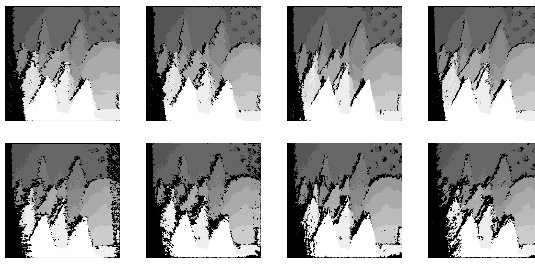
Figure 3. Matching results for different path directions From the experiments, the matching effect of single path in